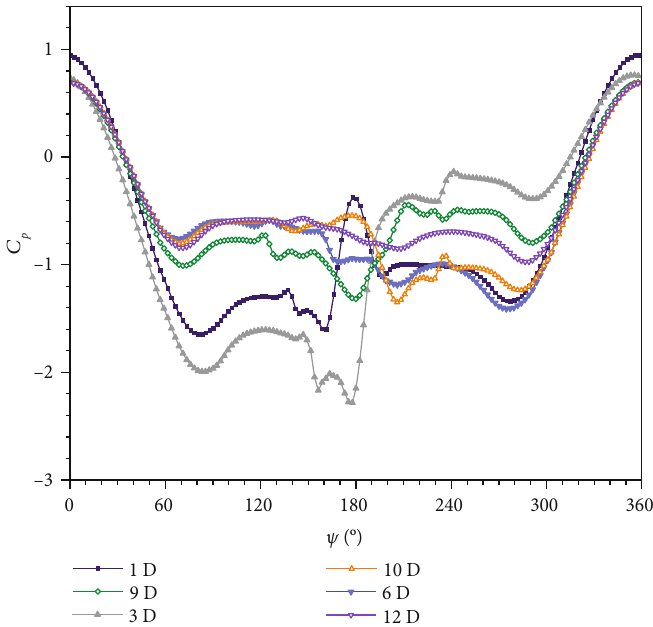
Figure 41: The pressure coe ffi cient of di ff erent sections varies with the roll angle at Model 1 with R a = 0 μ m.